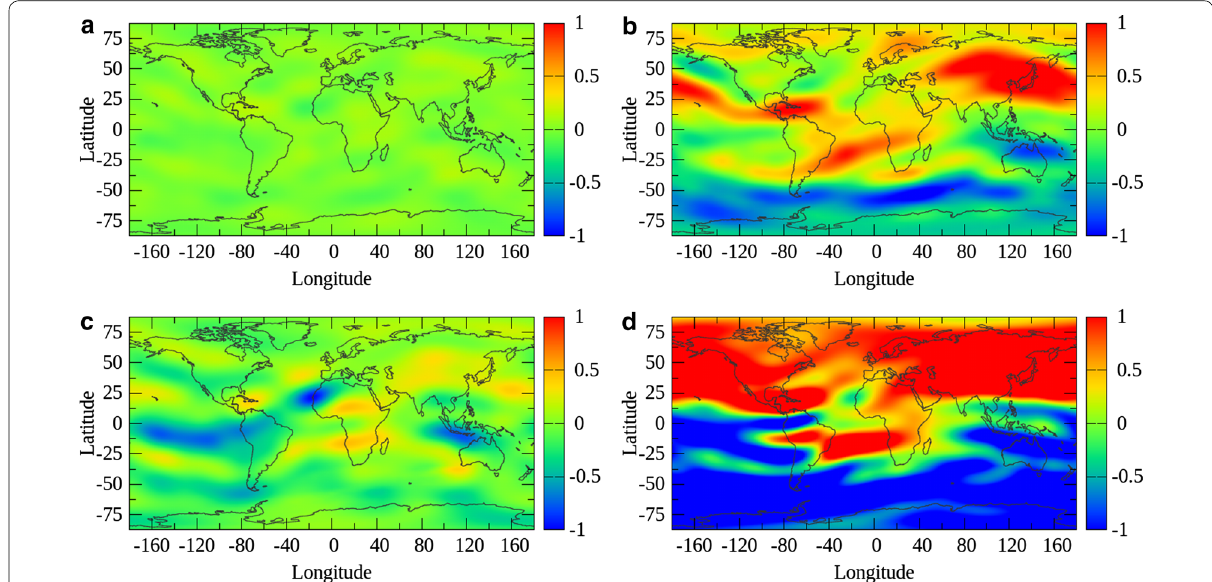
Fig. 8 Bias of the differences between forecasting products ARPG and C1PG, and the final CODG product in 2009 and 2015. a Bias of ARPG minus CODG in 2009. b Bias of C1PG minus CODG in 2009. c Bias of ARPG minus CODG in 2015. d Bias of C1PG minus CODG in